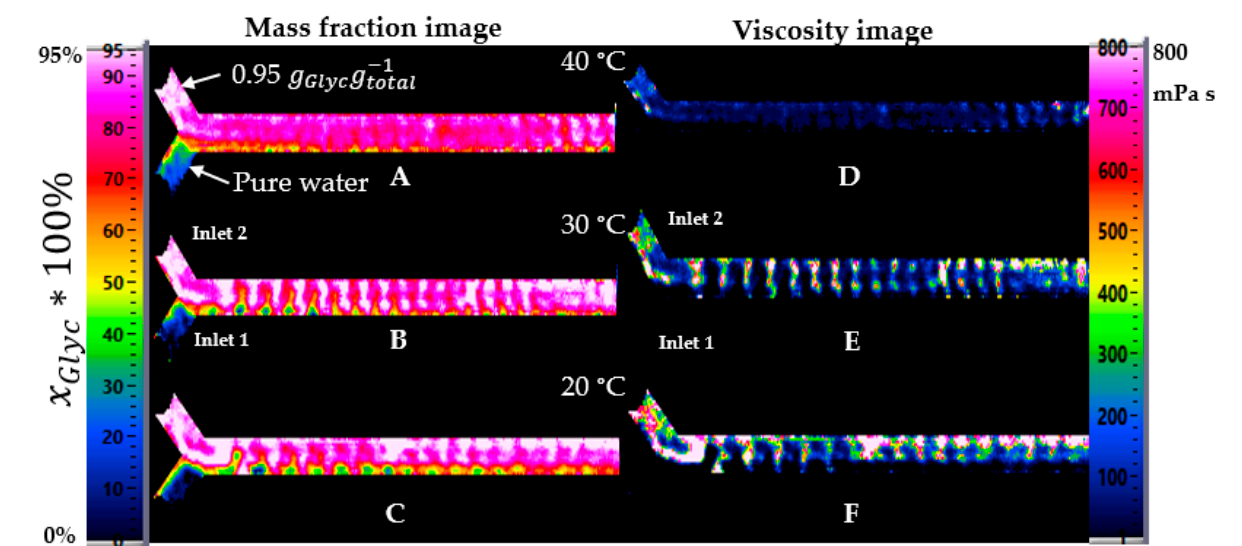
Figure 10. Effect of the temperature on the concentration in mass fraction mapping from channel at 40, 30, and 20 ◦ C ( A – C ) for a large difference of viscosity between inlet 1 water and inlet 2 with 0.95 g Glyc g − 1 . ( D – F ) Viscosity mapping from channel at these three temperatures.